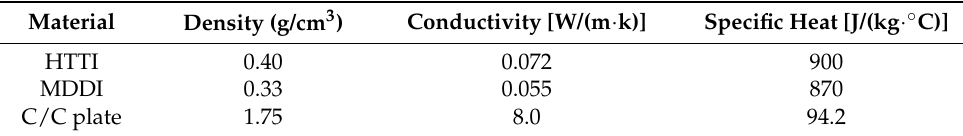
Figure 7. Illustration of TPS structure for the hypersonic wing. ( a ) Three regions in the hypersonic wing; ( b ) Multilayer TPS; ( c ) Geometry of the multilayer tile; ( d ) FEM model of the multilayer tile. Table 4. Physical properties of the multilayer